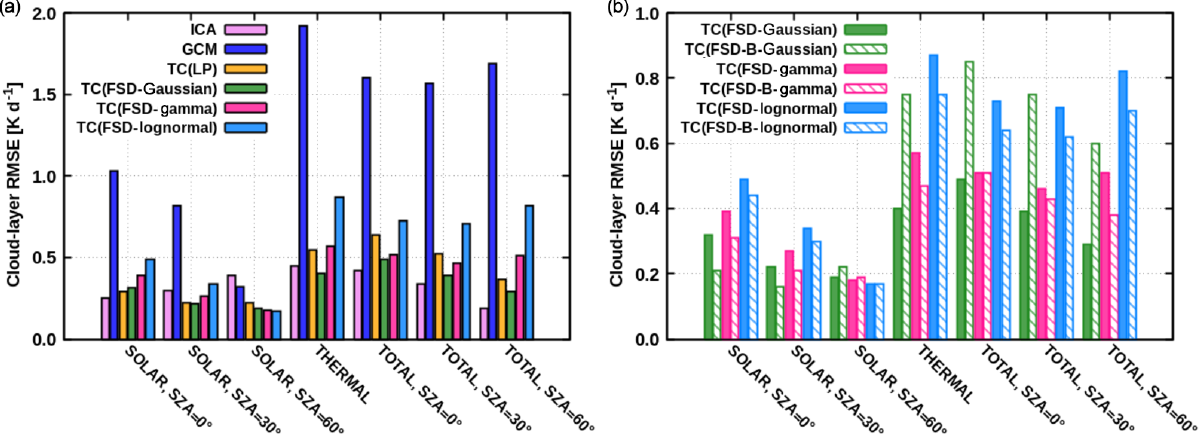
Figure 13. (a) RMSE for the ICA, GCM and TC experiments. (b) Comparison of the TC experiments using the FSD method in the baseline setup with global estimate and with the parameterization of Boutle et al. (2014) (denoted as “B”). Note the different scales on the y axis.